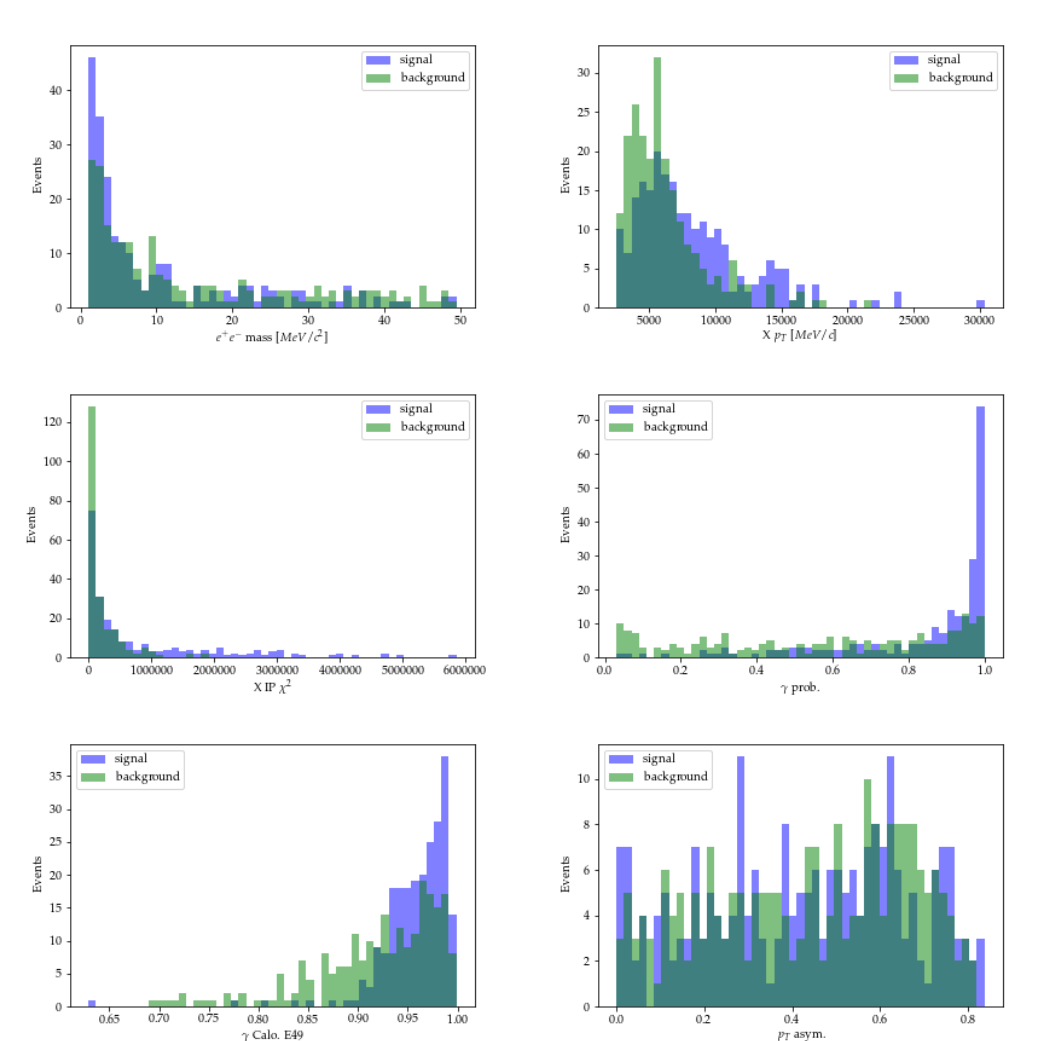
Figure 2: Signal and background distributions of information used to train the 1CV LL classifier. Variables are explained in the